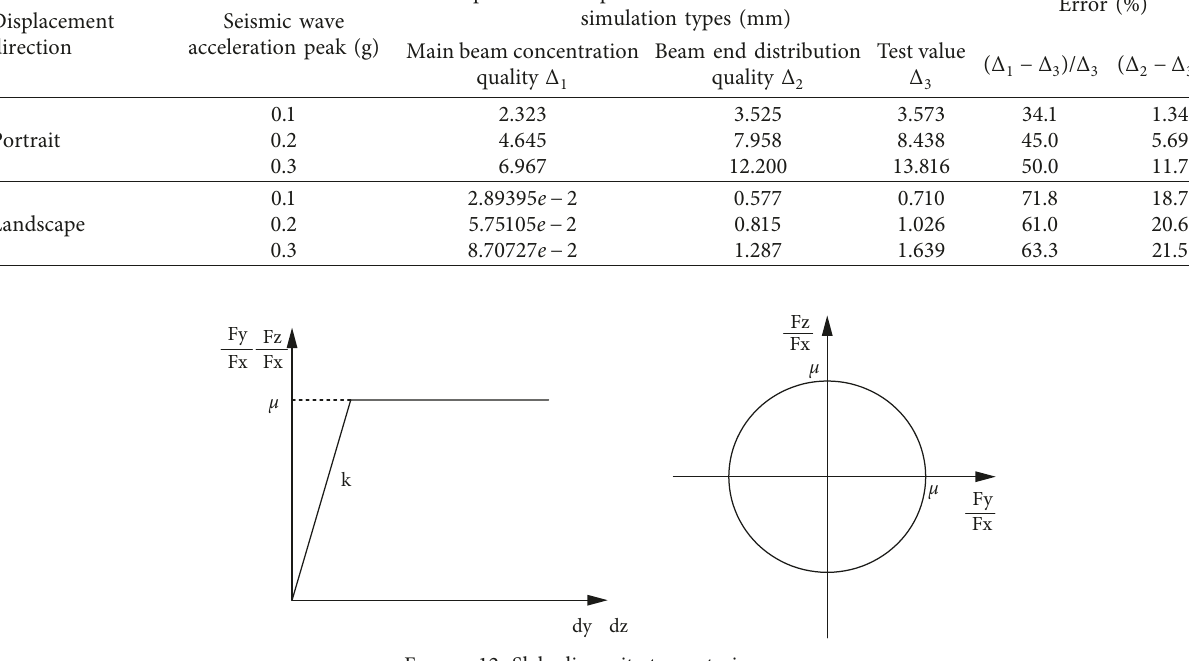
Figure 12: Slab-slip unit stress-strain